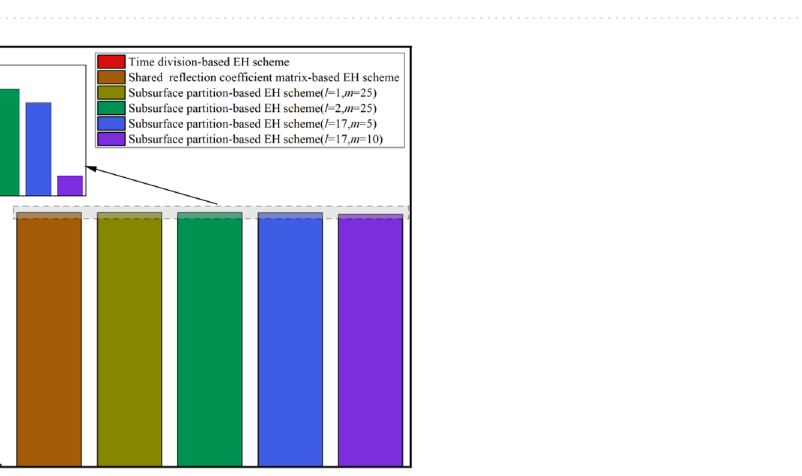
Figure 5. Heat maps for exhibiting the amount of energy harvested by each CRSNs node in different EH schemes.